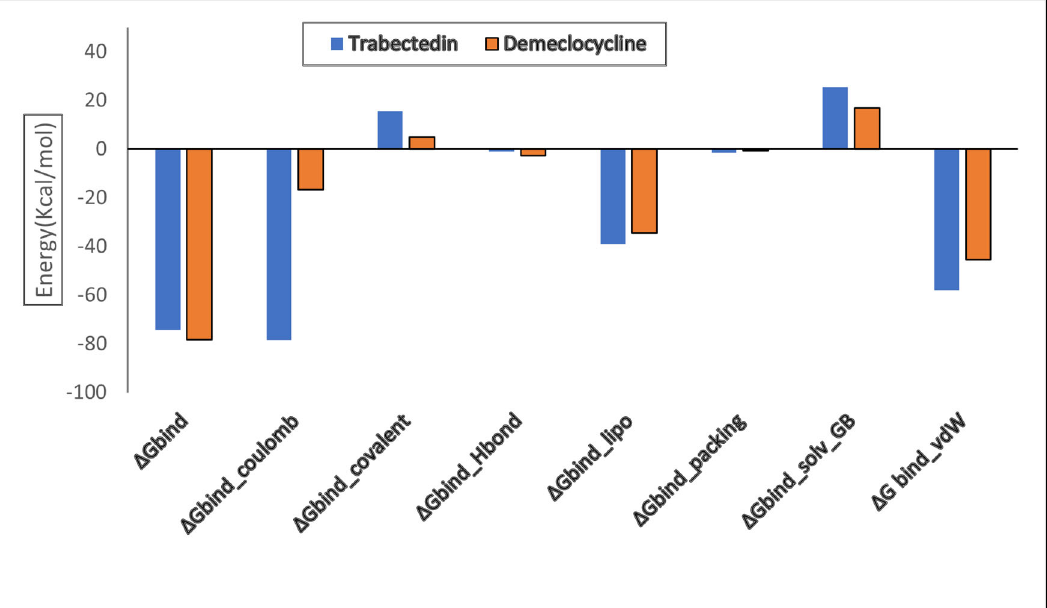
Figure 15. Histogram of calculated binding free energy values of the two best compounds in contact with receptor via the MM-GBSA method.